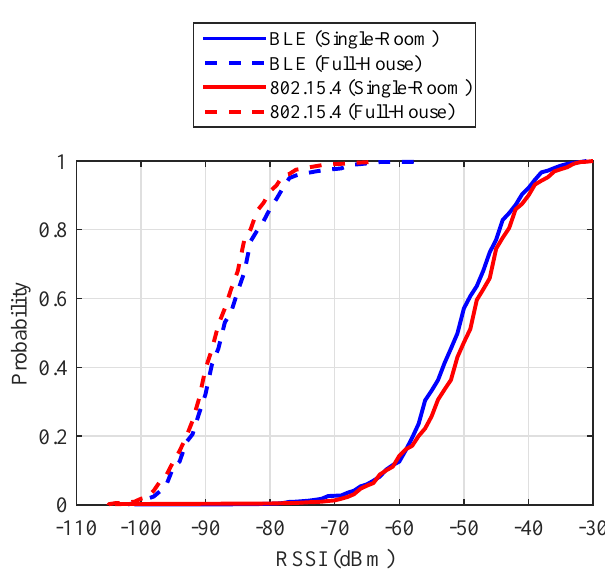
Figure 7. Empirical CDF of the RSSI when the transmitter and the receiver are in the same room (single-room coverage) and separated by two walls (full-house coverage).